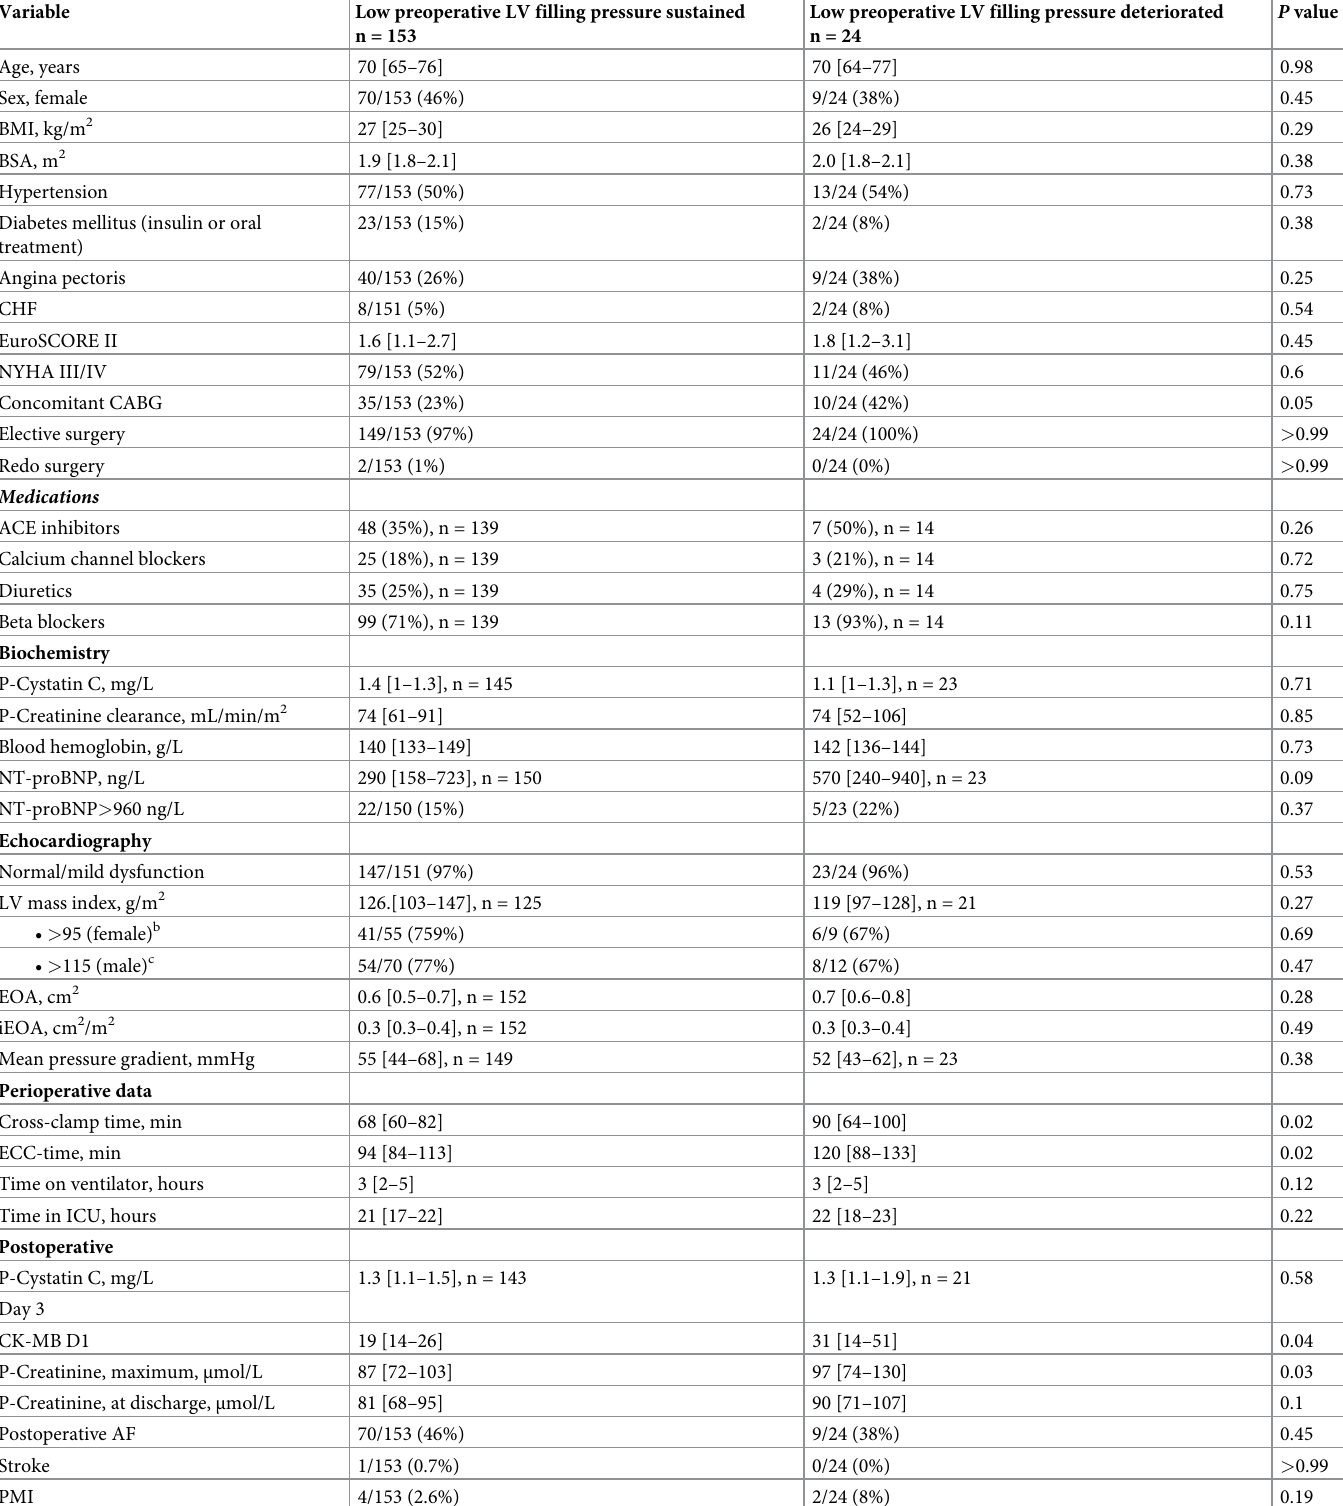
Table 3. Data from patients with preoperative low filling pressure a